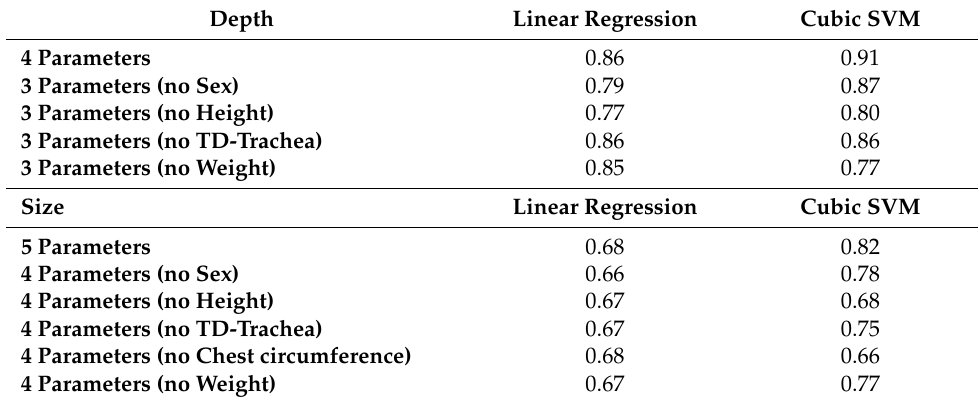
Table 6. Results compared for two models: linear regression, and SVM, with full sets of parameters, or with